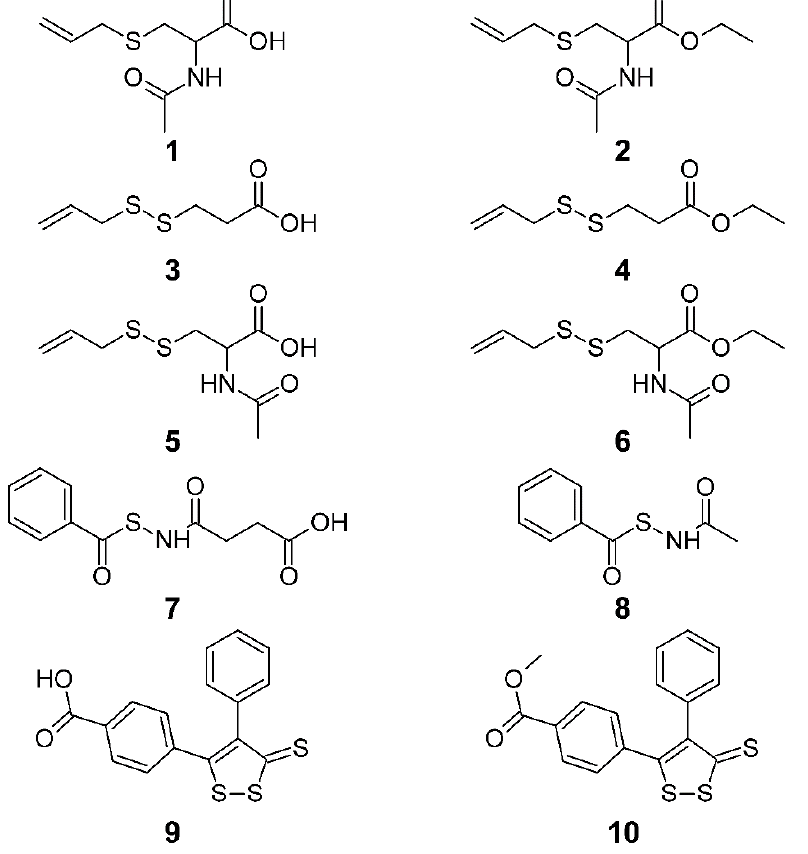
Figure 1. Structures of H 2 S donor molecules.